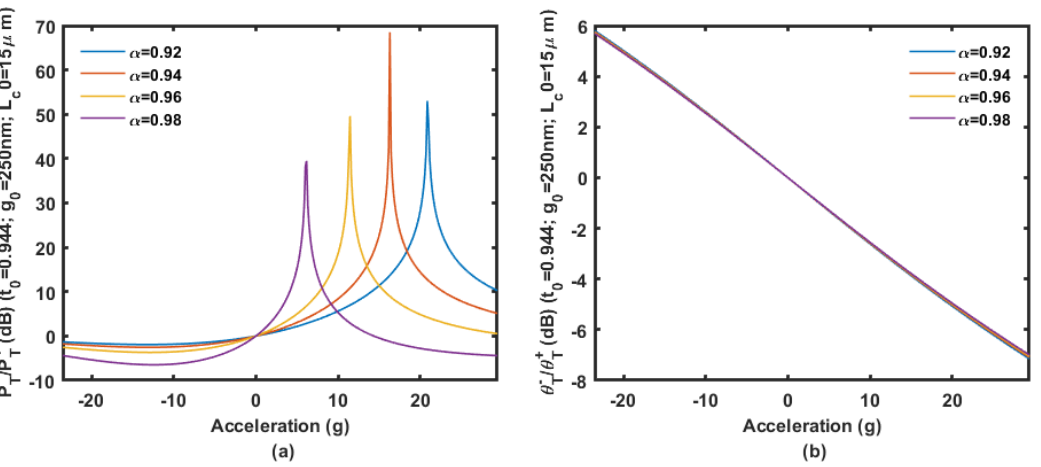
Figure 15. Output characteristics of the accelerometer illustrated by power ratio ( a ) and phase ratio ( b ).